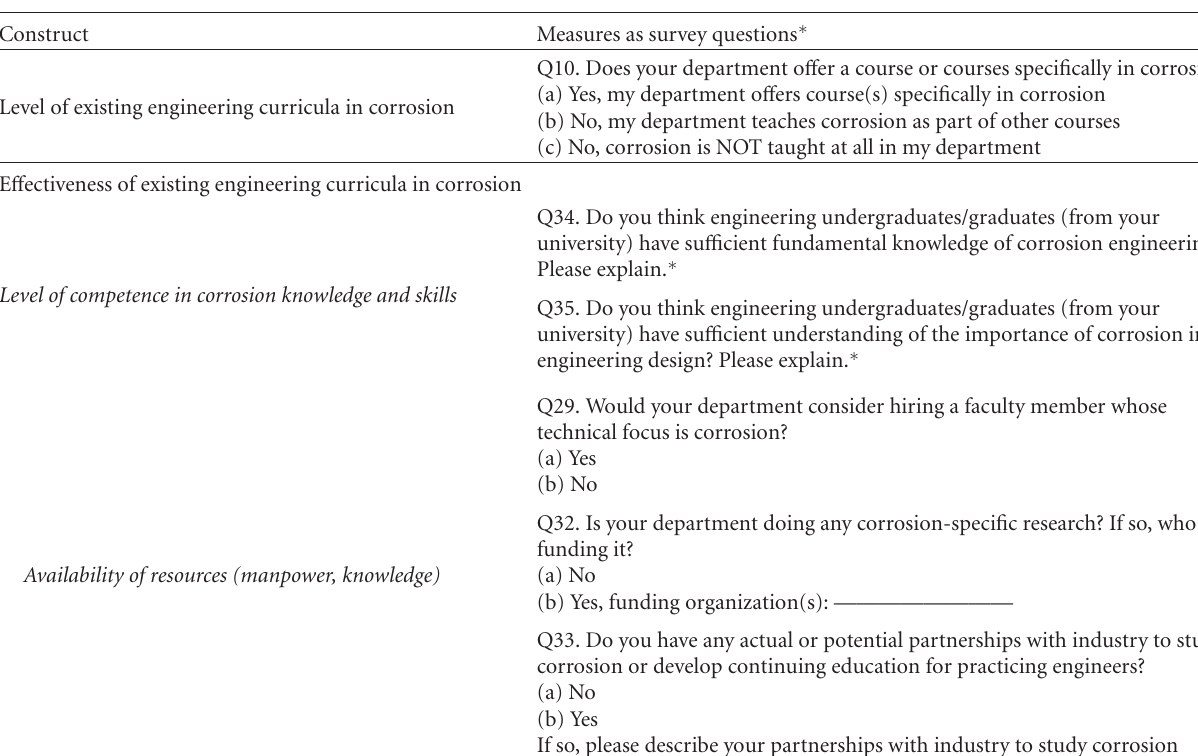
Table 2: Measures for